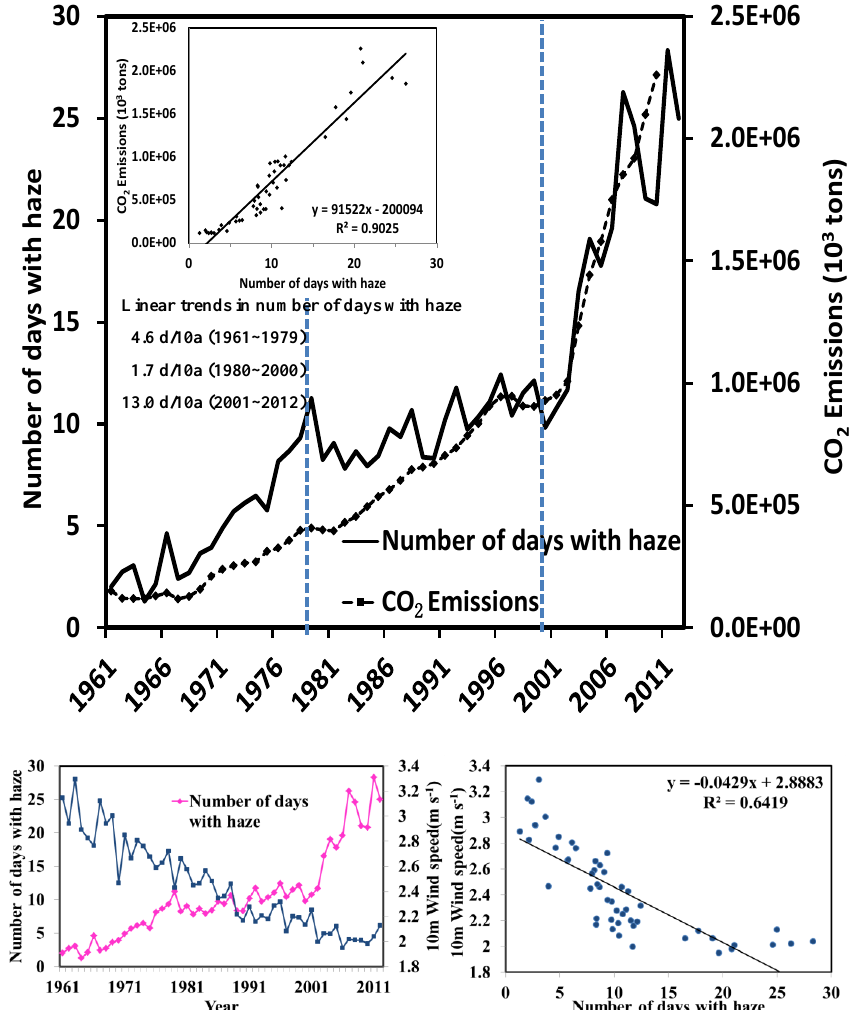
Figure 1. Interannual variations in the total CO 2 emissions in mainland China and the haze event frequency averaged in the CEC region over 1961–2012 with their relationship in the inserted figure (upper panel). The Chinese CO 2 emission data source: http://cdiac.ornl.gov/ CO2_Emission/timeseries/national. Two blue dotted lines separate the time series into three phases of the 1960s–1970s, the 1980s–1990s and the twenty-first century. Interannual variations in wind at 10m (blue line) and the number of days with haze (red line) in the CEC over 1961–2012 (lower-left panel) and their scatter plot (lower-right